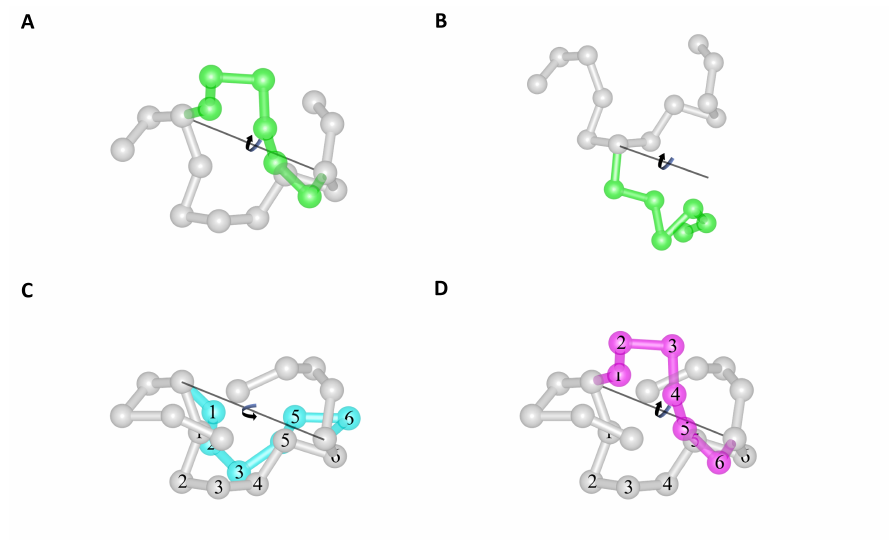
Figure 8. The move set. ( A ) Crankshaft move: Axis passes through two randomly selected beads and the beads between these are rotated around the axis. ( B ) Pivot move: Axis passes through one randomly selected bead, and the beads between that and a randomly selected terminus are rotated around the axis. ( C ) LTyP move variant: The rotated segment can reach the cyan conformation without passing across any fixed segment, hence the linear topology of the chain is preserved. ( D ) non-LTyP move variant: The magenta conformation can only be reached by the rotated segment by either moving across the front or across the back fixed segments; hence, the linear topology of the chain is not preserved in this crankshaft